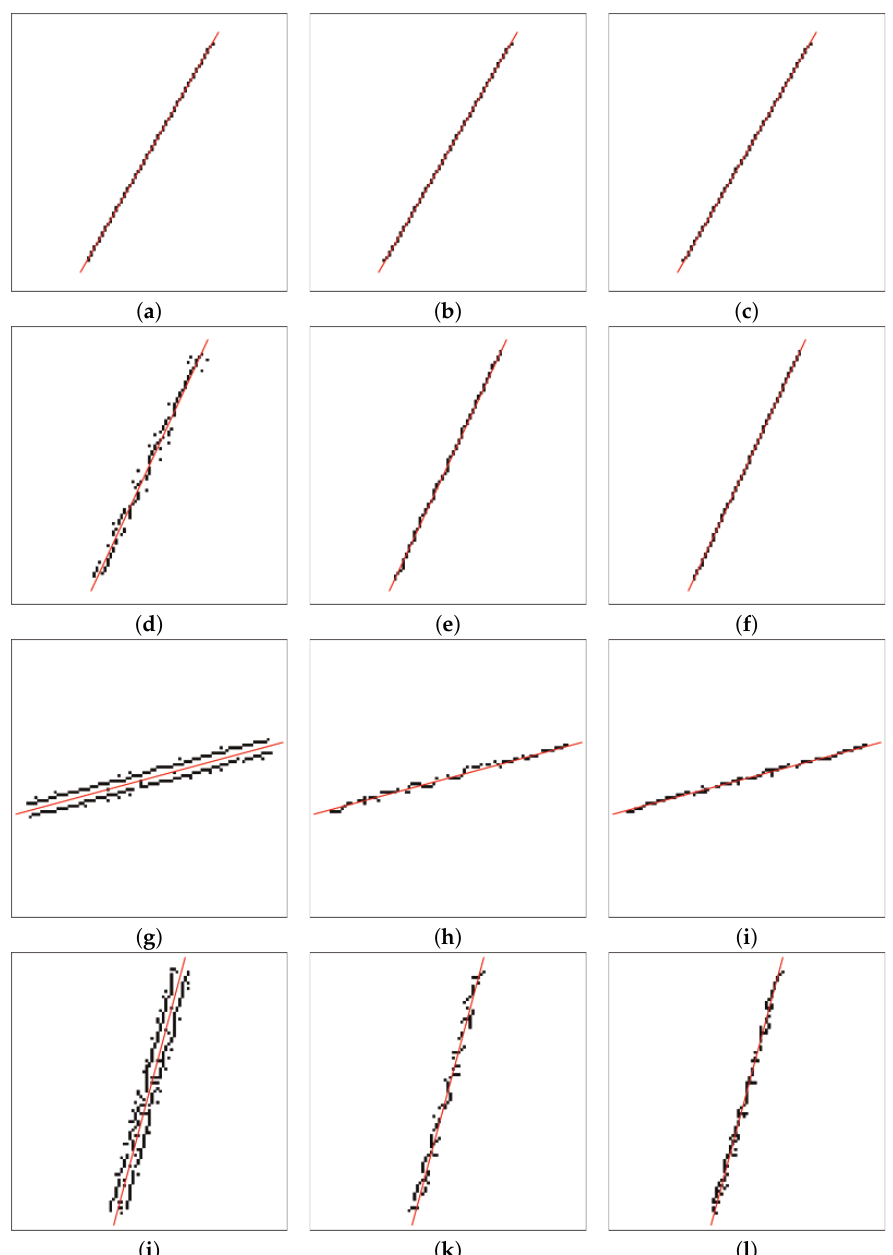
Figure 5. Detection results of second-derivatives (SD)-, extremity-count (EC)-, and sum of gradient angle differences (SGAD)-based methods for simulated images with ( a – c ) noise strength σ n = 10/255, line width w = 2, and line normal angle θ = 30 ◦ ; ( d – f ) σ n = 30/255, w = 6, and θ = 25 ◦ ; ( g – i ) σ n = 30/255, w = 8, and θ = 75 ◦ ; and ( j – l ) σ n = 60/255, w = 8, and θ = 15 ◦ . (column 1) SD-, (column 2) EC-, and (column 3) SGAD-based line-detection approaches. The red lines indicate the true center lines of the simulated line